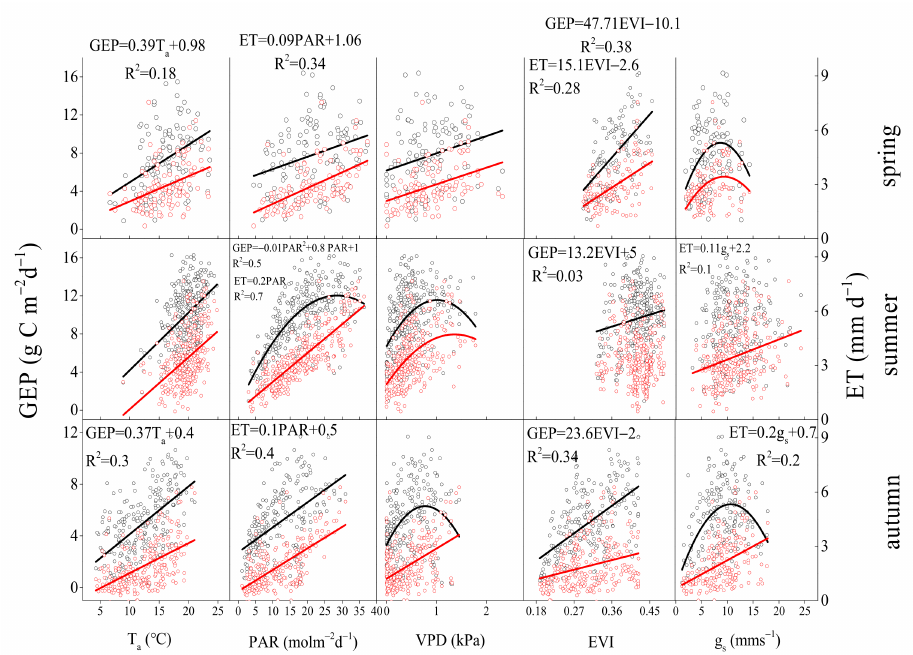
Figure 7. Relationships of daily gross ecosystem productivity (GEP), evapotranspiration (ET) with daily environmental factors (T a , PAR, VPD) and biological factors (EVI, midday g s ) in three seasons (spring, summer, autumn) from 2017 to 2020.